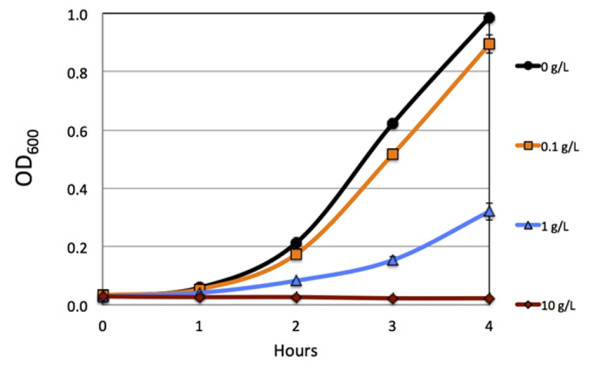
Comparison of growth with isobutyraldehyde stress. Time courses for the growth of E. coli strain AL626 (JCL260 ΔyqhD ΔadhP ΔeutG ΔyiaY ΔyjgB ΔbetA ΔfucO) in the presence of 0 (black), 0.1 (orange), 1 (blue), and 10 g/L (red) isobutyraldehyde in 15 ml screw-cap tubes. Optical density (OD) measurements taken every hour for 4 hours at 600 nm. Error bars represent the standard deviation of triplicate experiments.